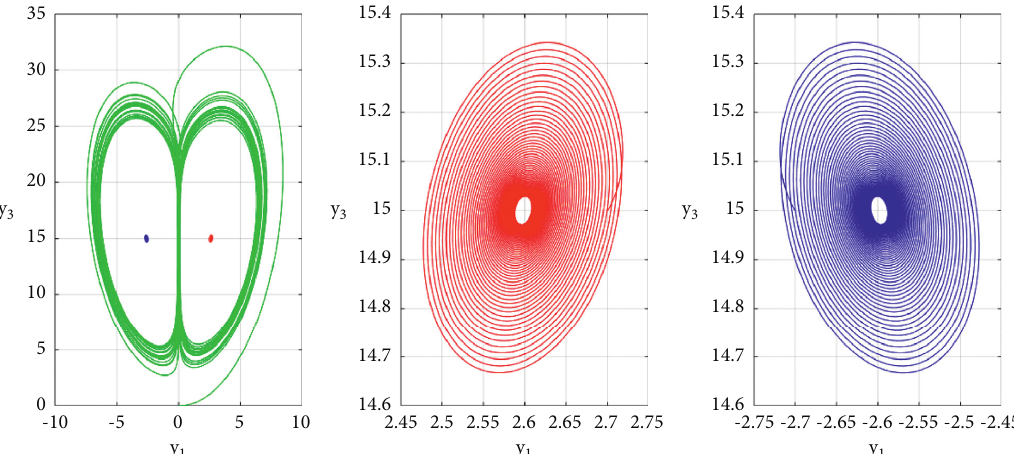
Figure 10: View of the integer-order Matouk’s system (4) in the y attractor (green plot), one-point attractor corresponding to Eq ( 2 ) � ( 2 . 5981 , 10 . 1 , 15 , 0 ) (red plot), and one-point attractor corresponding to Eq ( 3 ) � (− 2 . 5981 , − 10 . 1 , 15 , 0 ) (blue plot).